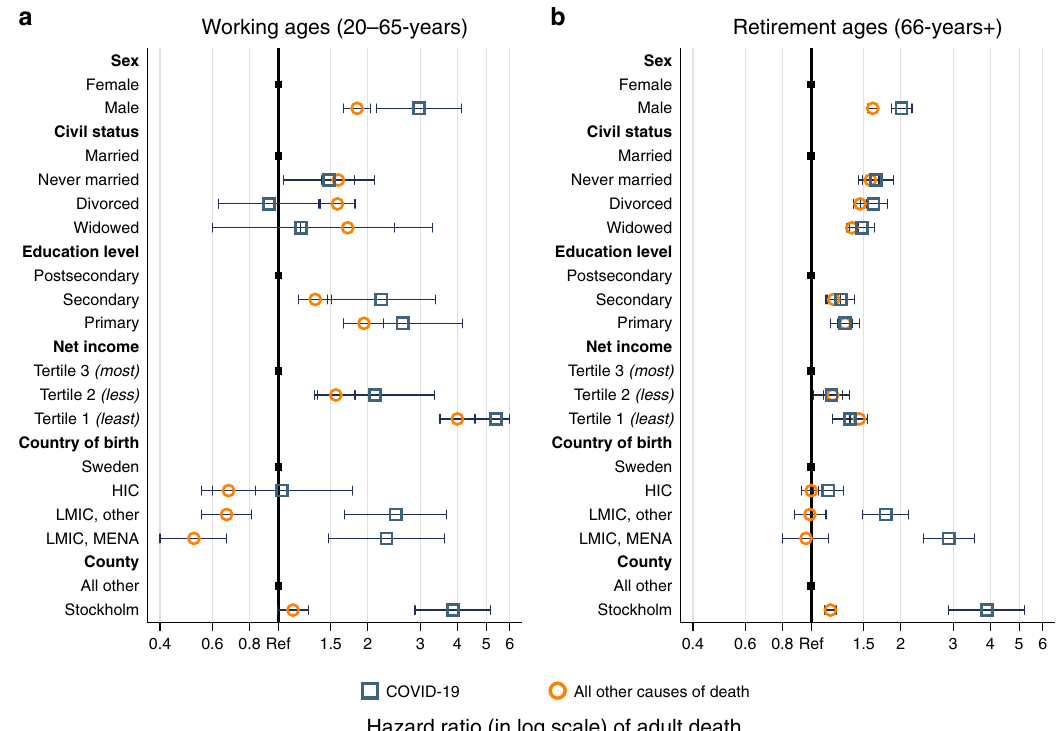
Fig. 2 Hazard ratios of dying from COVID-19 and all other causes of death for working ages and retirement ages. a Working ages (20 – 65 years), error bars representing 95% con fi dence intervals of hazard ratios, n = 5,813,359 individuals. b Retirement ages (66 years and older), error bars representing 95% con fi dence intervals of hazard ratios, n = 1,979,710 individuals. Blue squares indicating COVID-19 mortality. Orange circles indicating mortality from all other causes of